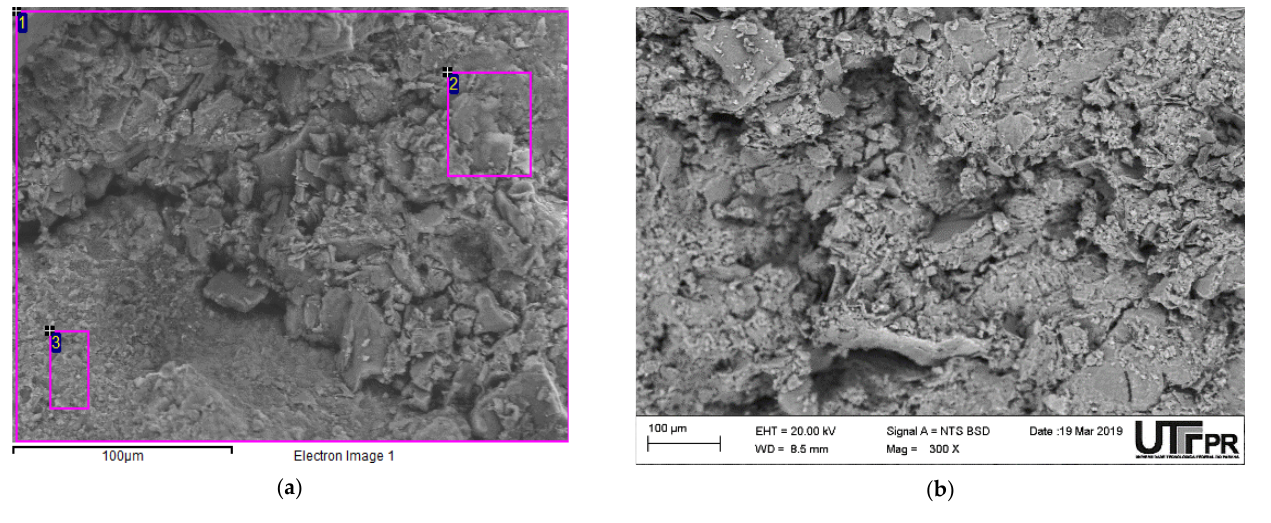
Figure 10. ( a ) Area positions of the EDX analyses (results in Table 5). ( b ) MEV of soil-cement-RT. Table 5. Chemical compositions (by EDX method) of the area for S+6%C+15%RT mix after 28 days of curing (see Figure